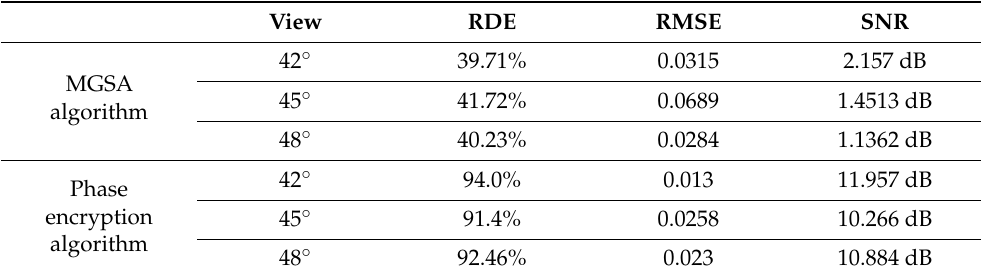
Figure 9. Reconstruction with same depth but different view ( a ) with phase-locked algorithm and ( b ) without phase-locked algorithm. Table 2. Assessment results of reconstruction images simulated with multi-angle phase encryption algorithm.